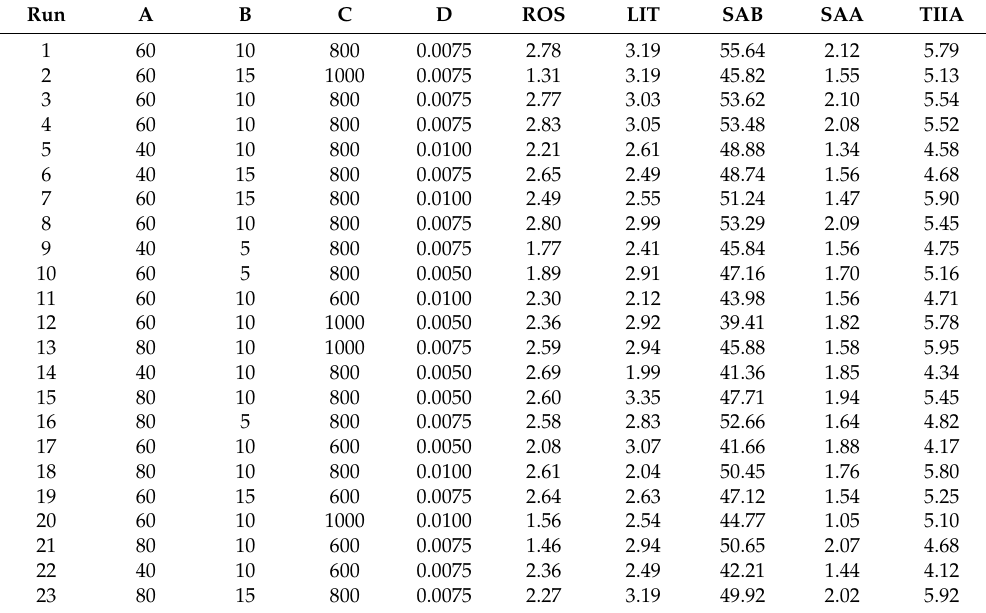
Table 2. Box–Behnken design with independent variables and measured responses.